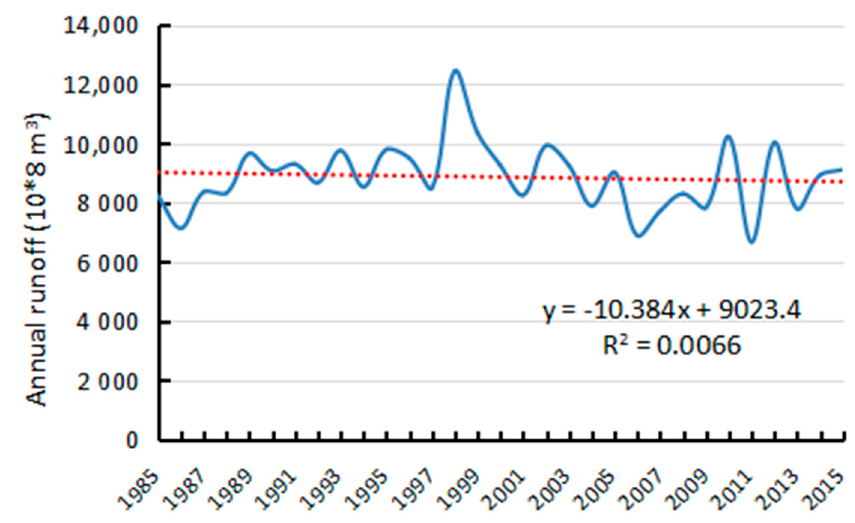
Figure 13. Annual runoff of Datong hydrological station (10 8 m 3 ).